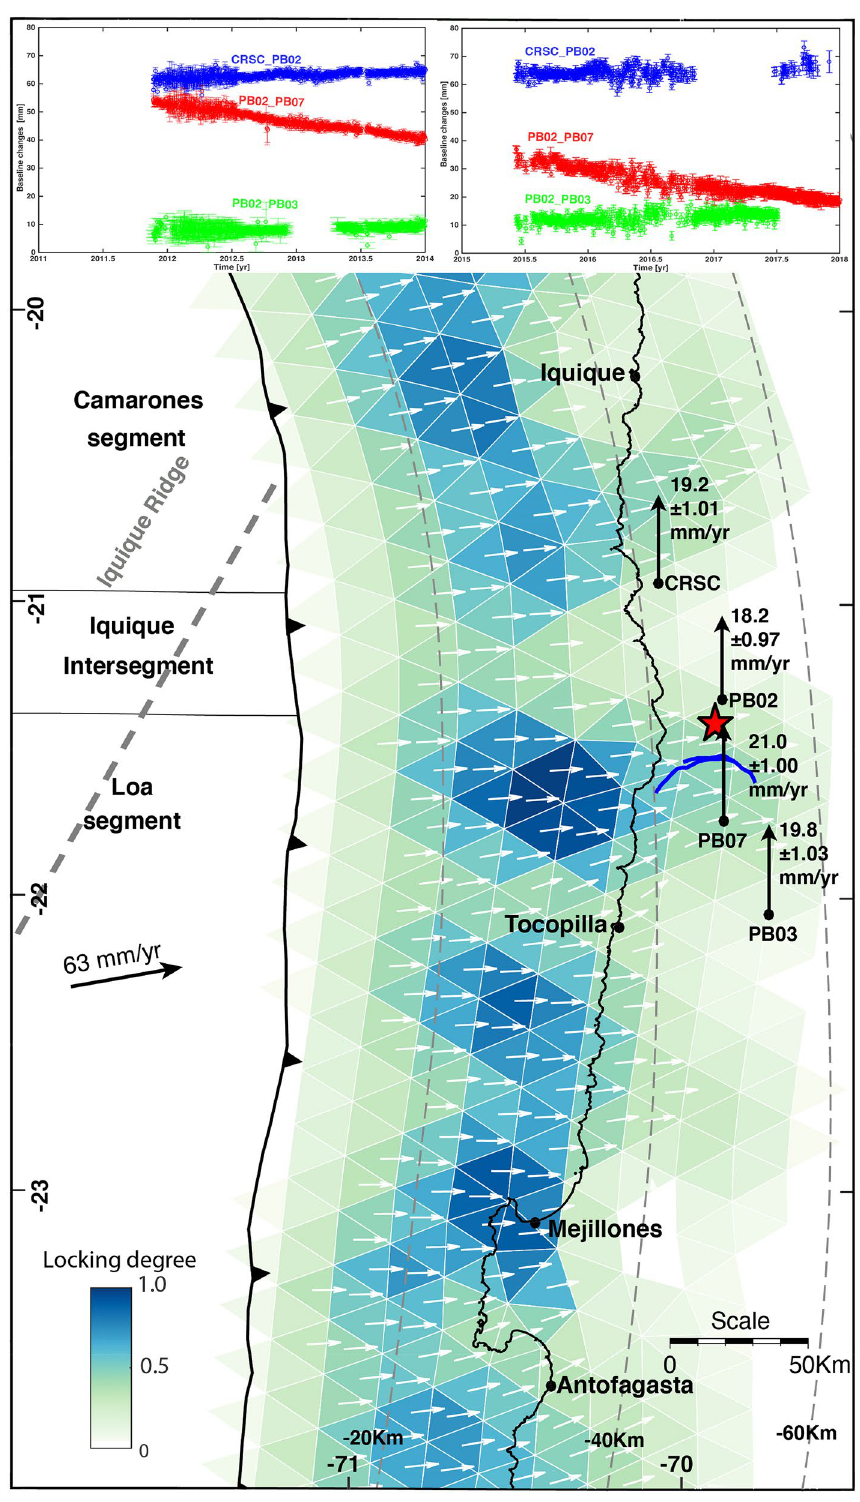
Figure 6. Interplate locking model before the M w Iquique earthquake 22 showing the cGPS sites used for the determination of the interseismic velocities expressed as the northern component. CRSC and PB02 are located in the intersegment Iquique LCZ and PB03 and PB07 are located in the Loa segment characterized by higher locking. The inset on the top right is the baseline formed by CRSC-PB02, PB02-PB07, and